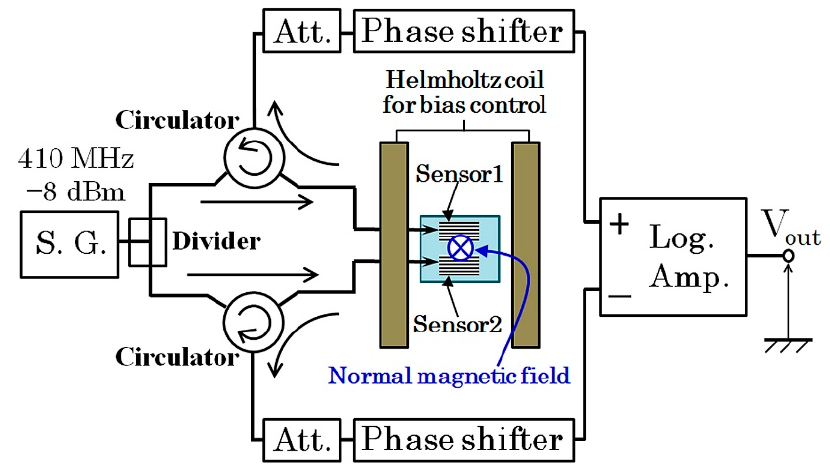
Figure 29. Block diagram of the driving circuit of differential sensor. Figure 30 is a photograph of measurement system of the differential detection experi- ment. A G-S-S-G non-magnetic wafer probe was use for contacting the sensor, and a soft magnetic small particle was 2D scanned using XYZ-manipulator. The measurement results are indicated as follows;